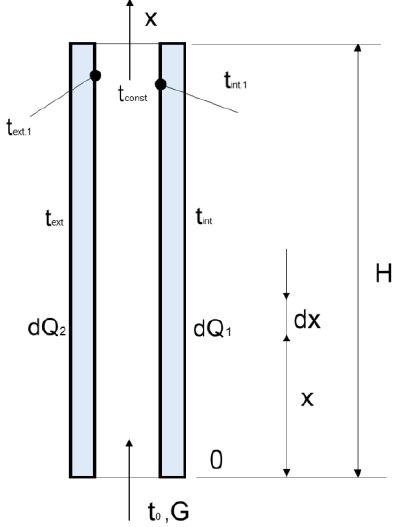
Figure 18. Scheme of a ventilated facade for calculation using the heat balance equation in a ventilated layer.